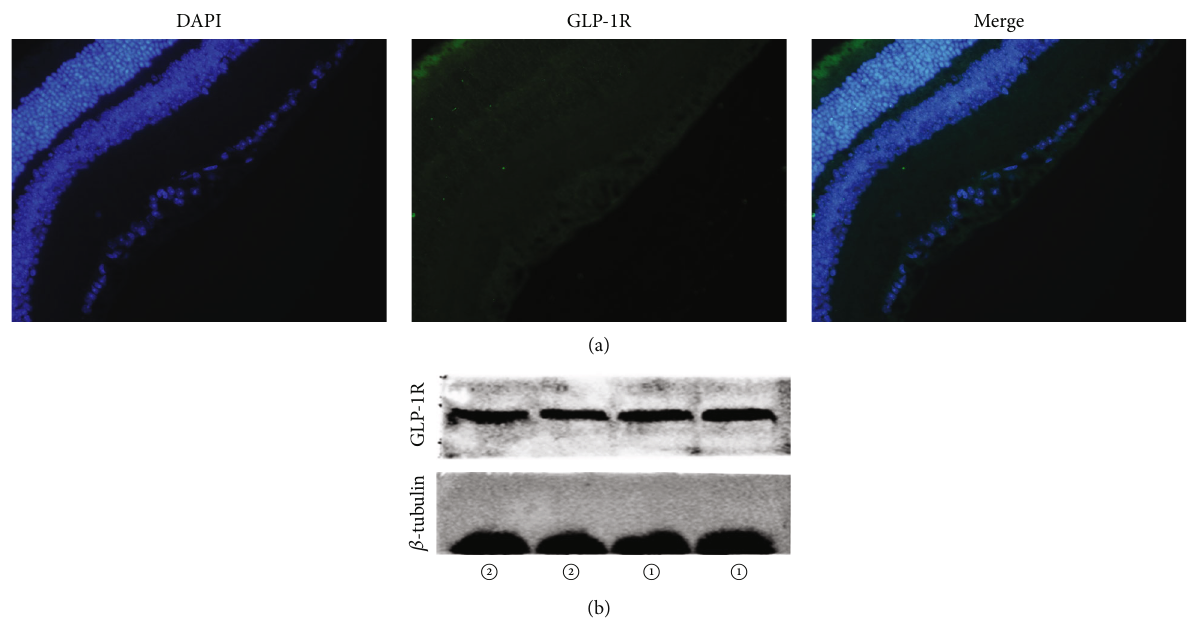
Figure 1: Expression of GLP-1R. (a) Immuno fl uorescence: GLP-1R was expressed in various layers of mouse retina (40x). (b) Western blot: GLP-1R was expressed in the mouse retina and INS 1 cells (rat insulinoma cells were used as positive control: (1) rat insulinoma cells and (2) mouse retinal